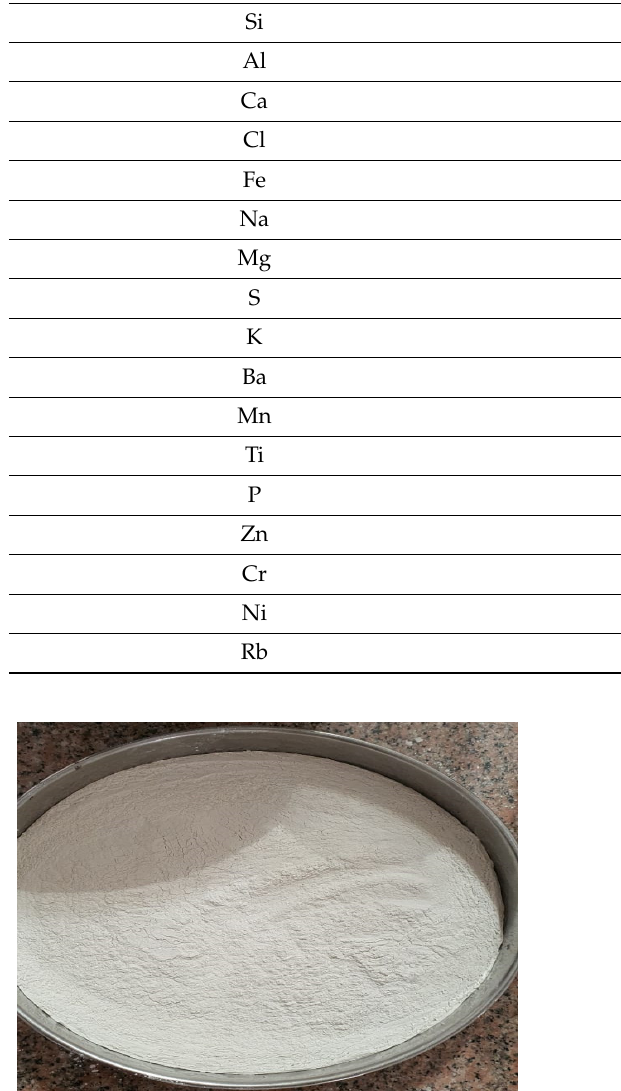
Table 1. Shear strength parameters for Sweileh and silica soils.